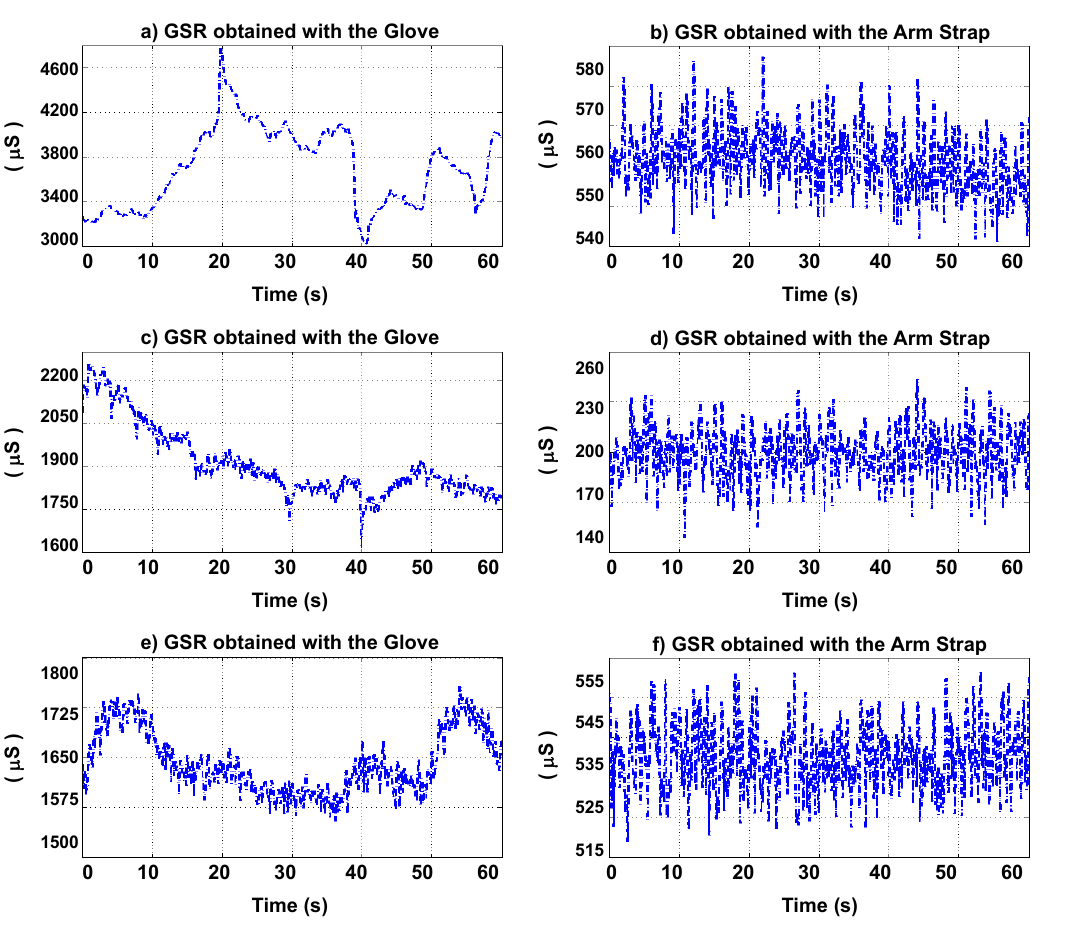
Figure A1. Galvanic skin response measurements. ( a ), ( c ) and ( e ) obtained with the glove and ( b ), ( d ) and ( f ) obtained with the upper arm